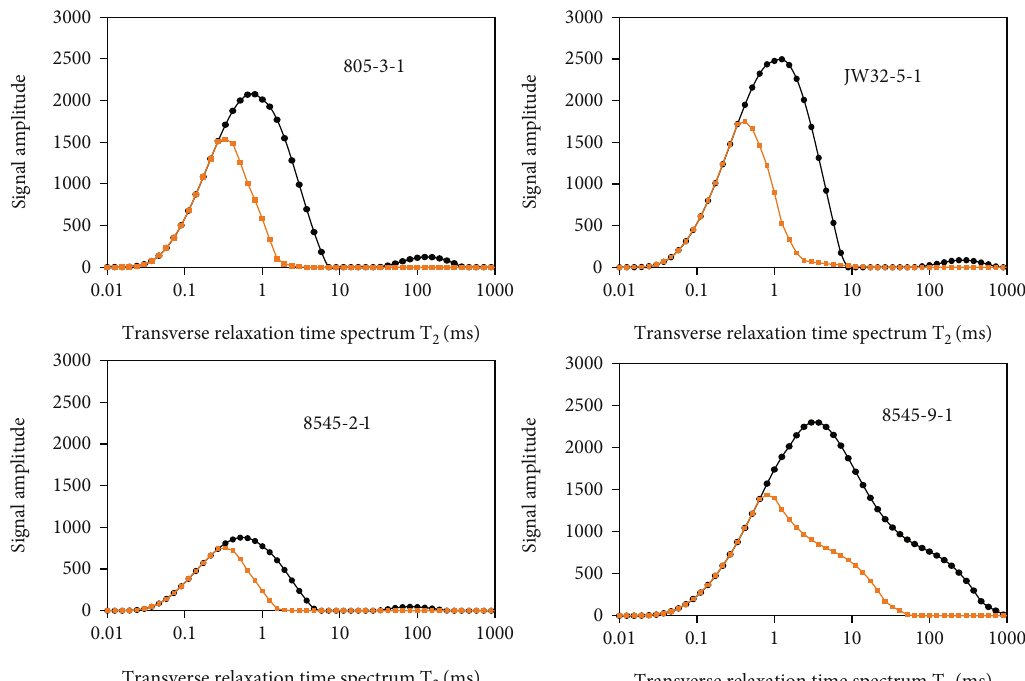
Figure 12: NMR curves of typical samples.